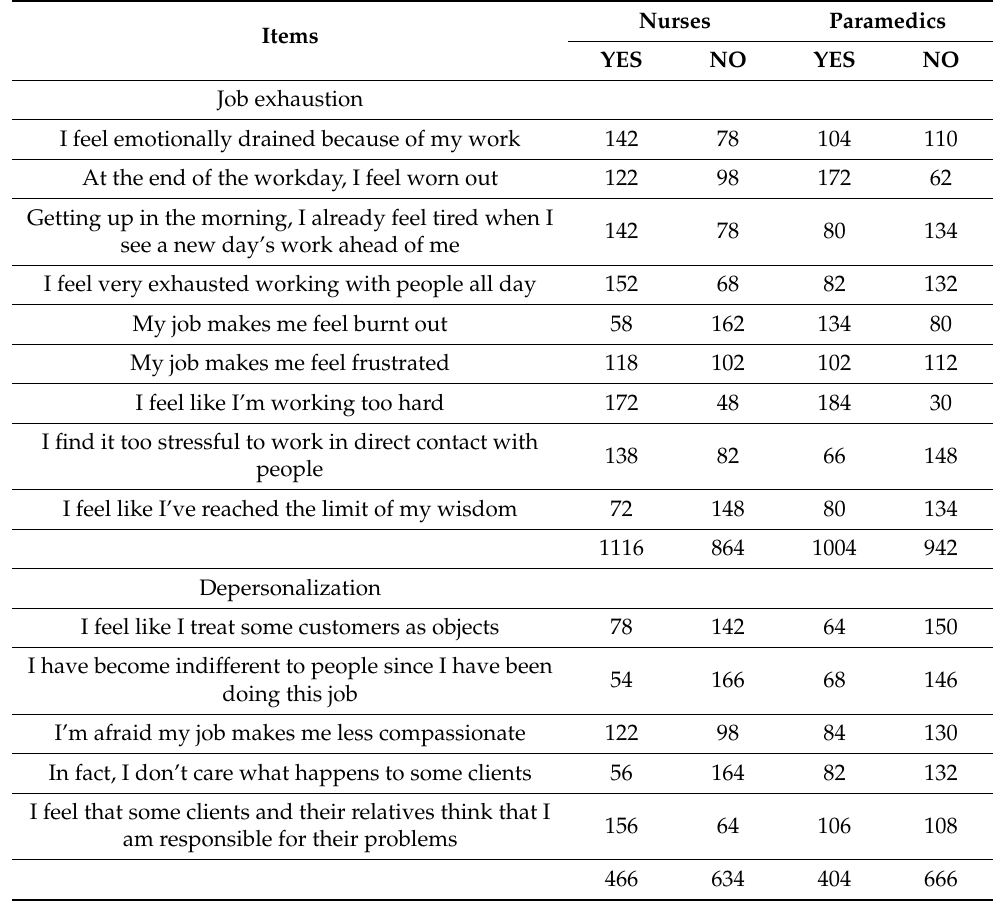
Table 3. Number of responses given by surveyed nurses and paramedics in each item of Ch. Maslach’s burnout questionnaire.